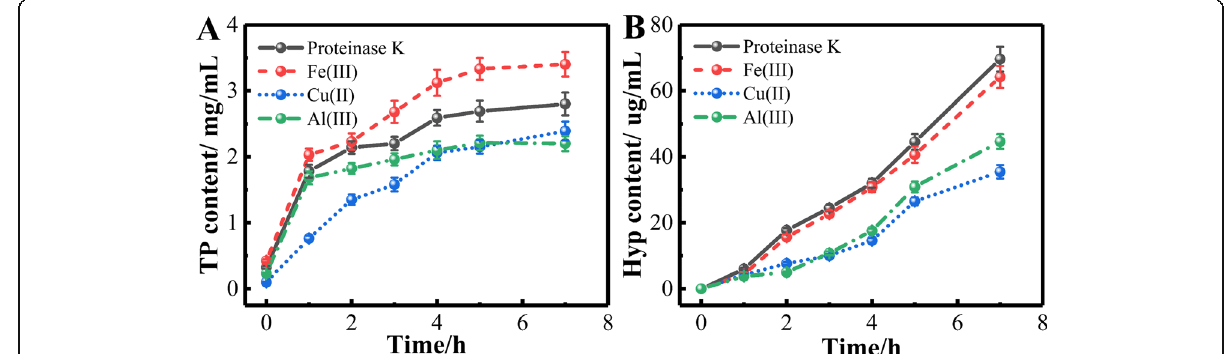
Fig. 3 Hyp and Total protein content in the float during enzymatic unhairing by adding metal ions